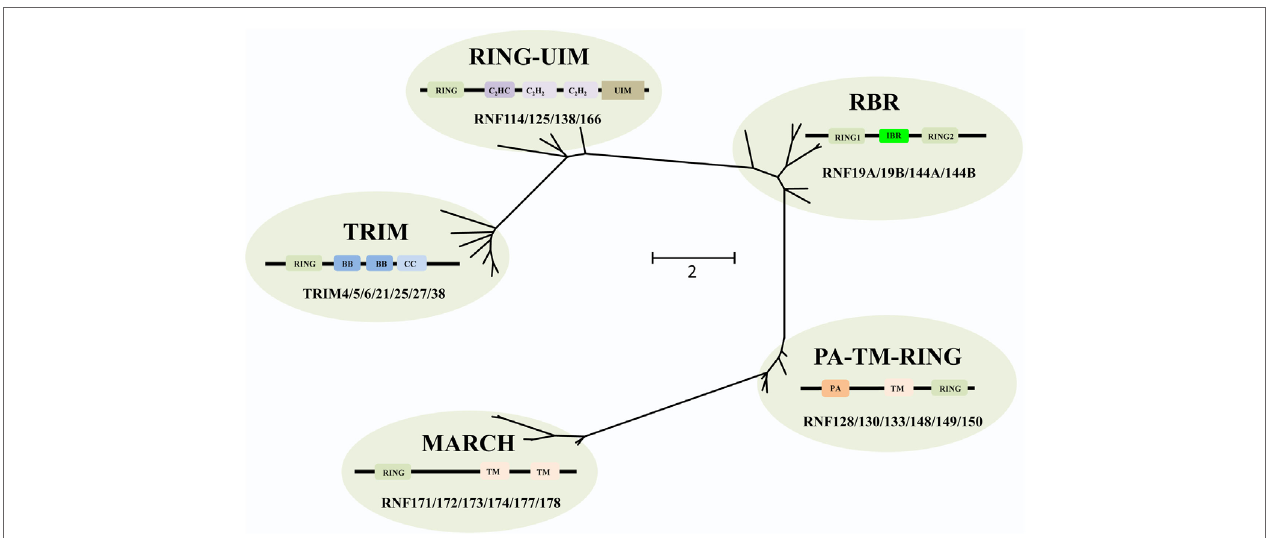
FiGURe 2 | Phylogenetic tree analyses of the RING-domain E3 ligases (RING E3s). Several examples of each type of RING E3s are shown. Each family has its special structure besides the conserved RING domain, which is shown as tawny. For tripartite motif-containing (TRIM) family, two B-box domains (BB), coiled-coiled domain (CC) are colored with dark blue and light blue, respectively. For membrane-associated RING-CH (MARCH) family, transmembrane (TM) domain is pink colored. For PA-TM-RING family, the protease-associated (PA) domain and two TM domains are colored orange and pink, respectively. For RING between RING (RBR) family, in-between-RING (IBR) domain is green colored. For RING-ubiquitin interacting motif (UIM) family, a C 2 HC-type zinc finger, two C 2 H 2 -type zinc fingers, and UIM are colored dark purple, light purple, and brown, respectively. Phylogenetic analysis was performed using